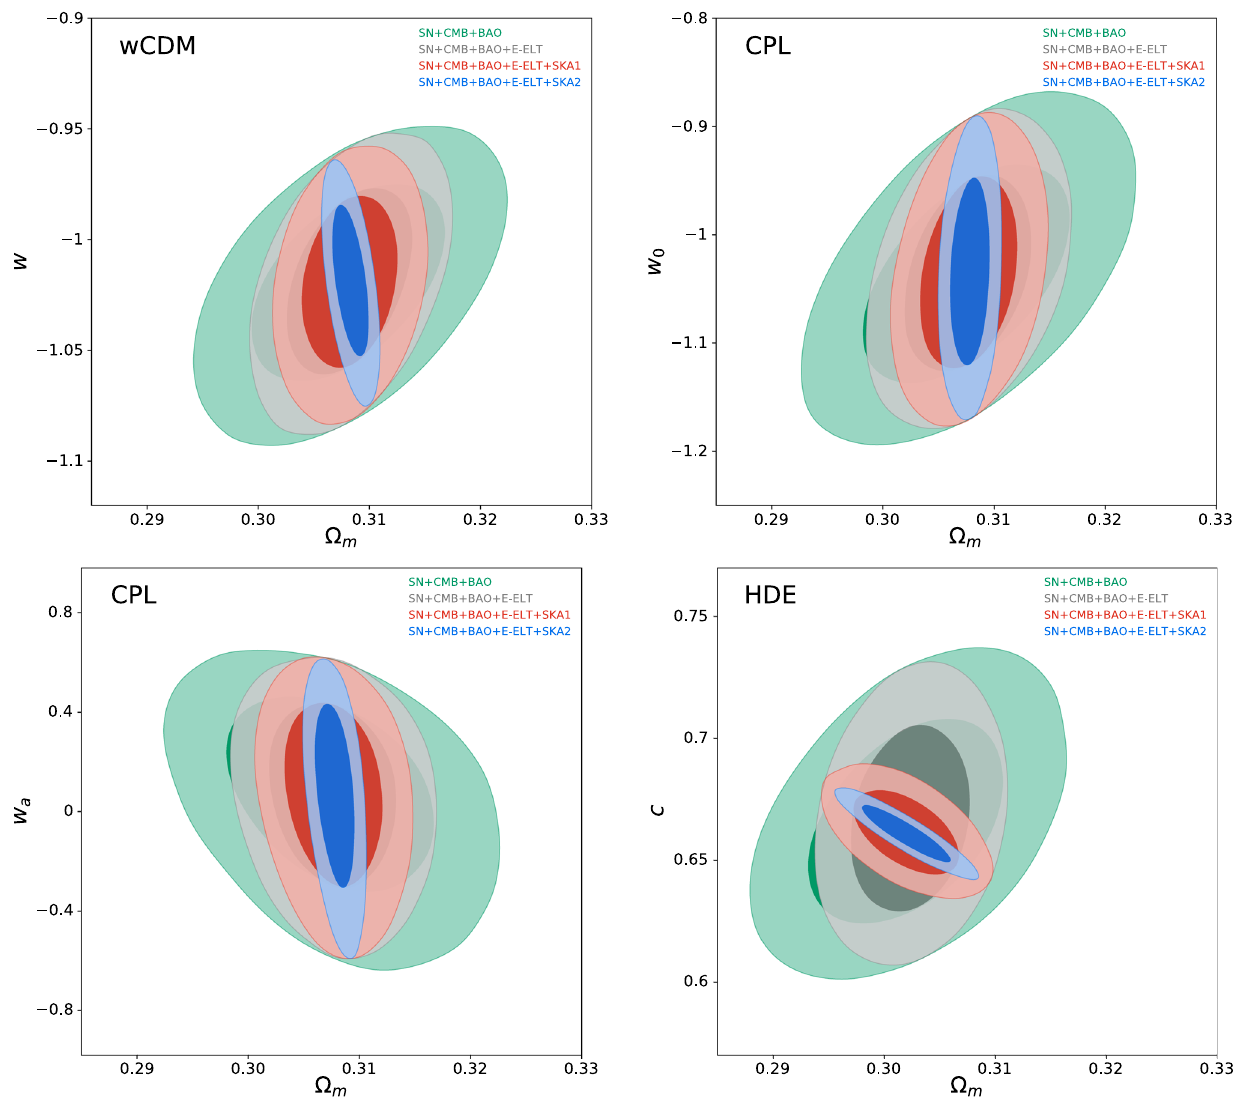
Fig. 5 Constraints (1 σ and 2 σ CL) in the (cid:4) m – w plane for w CDM model, in the (cid:4) m – w 0 plane for CPL model, in the (cid:4) m – w a plane for CPL model, and in the (cid:4) m – c plane for HDE model from